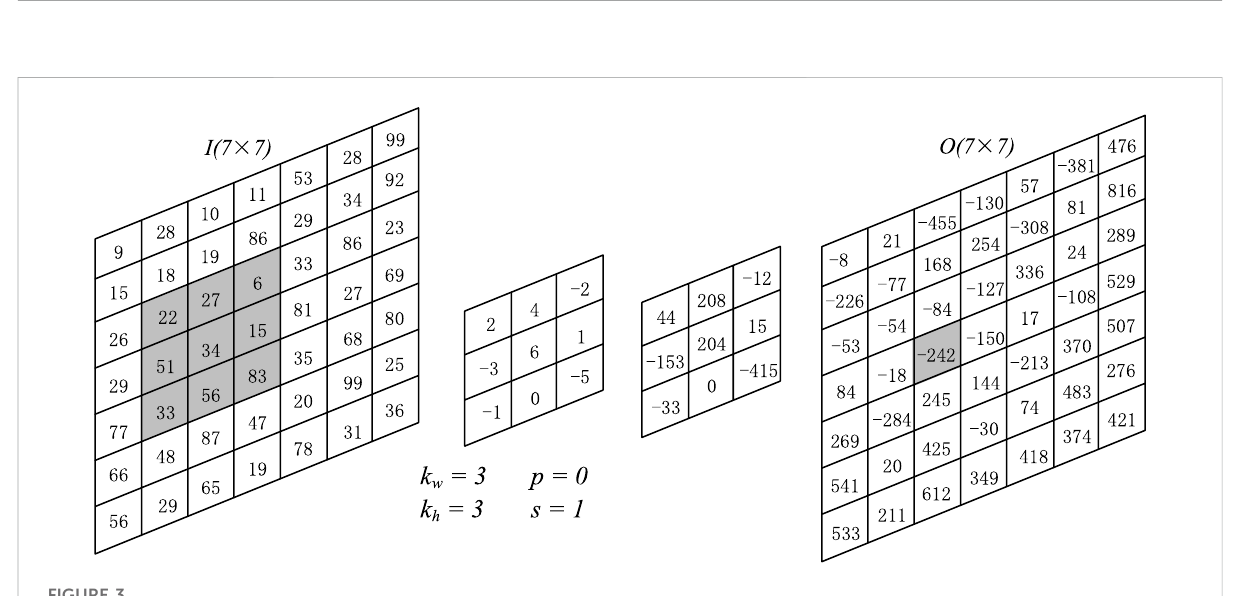
FIGURE 3 Result of Convolutional with a kernel of size 3 × 3 × 1 with stride = 1 to an image of size 7 × 7 with a single channel.